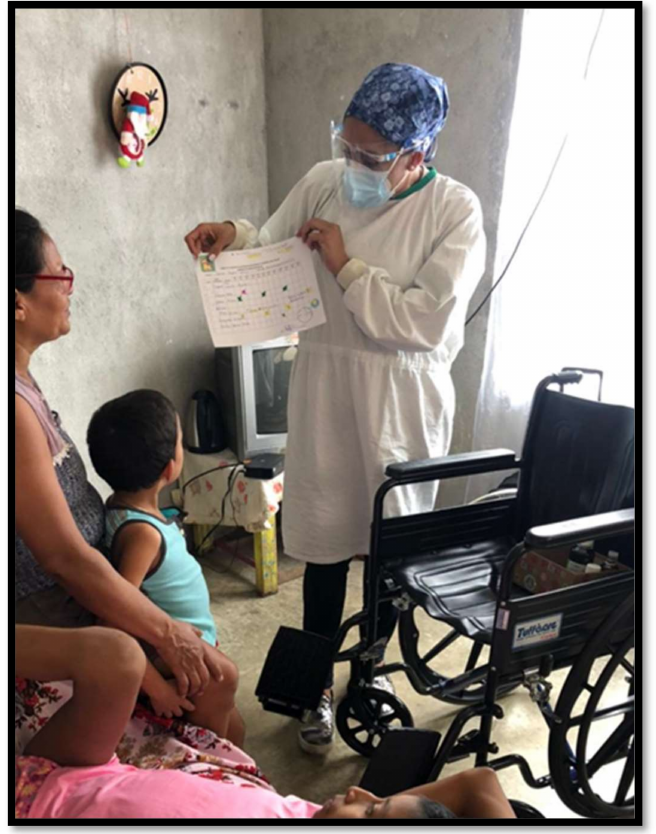
Figure 2. Education to a patient’s family in Costa